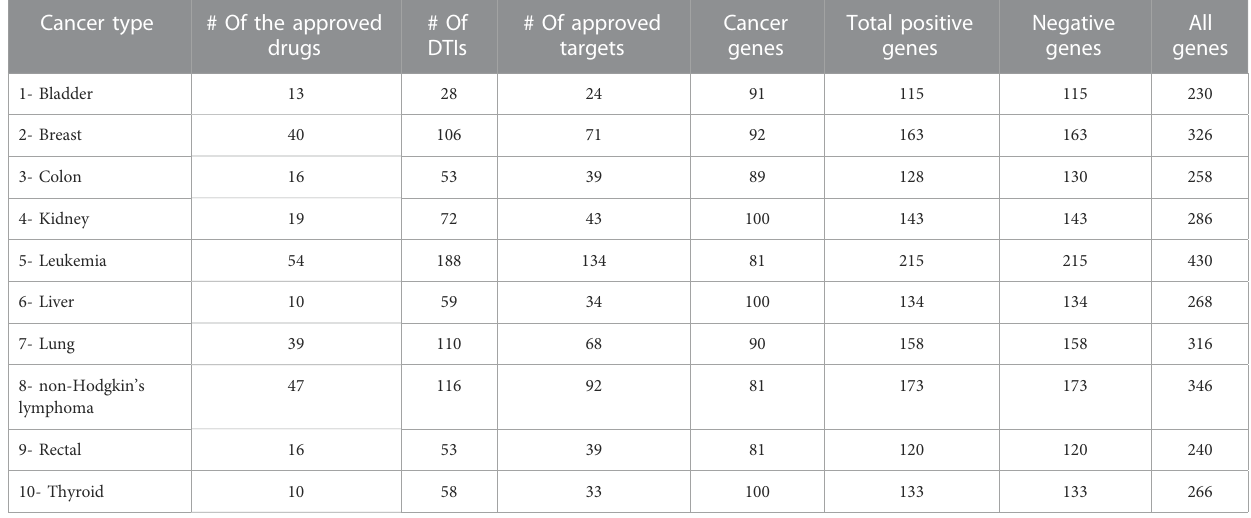
TABLE 1 OncologyTT dataset statistics for the ten cancer types. Each cancer type includes the number of anticancer drugs, targets that interacted with drugs, the unique targets with no duplicates, over-regulated cancer driver genes, and the total number of positive and negative genes. Cancer type